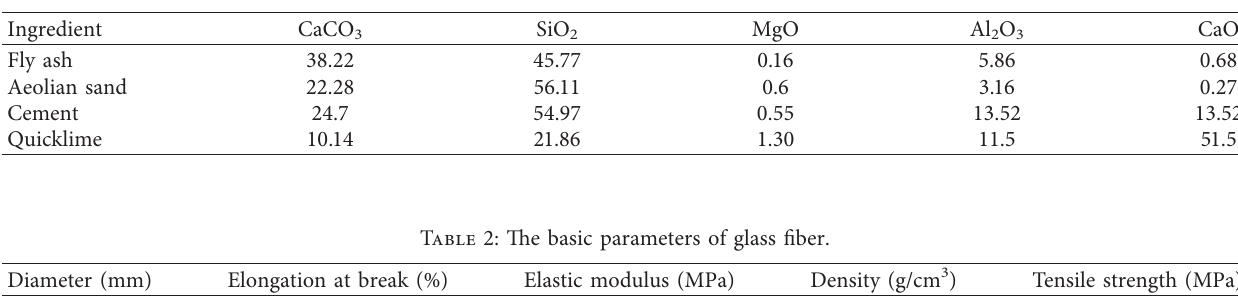
Table 1: Chemical composition of the raw materials.